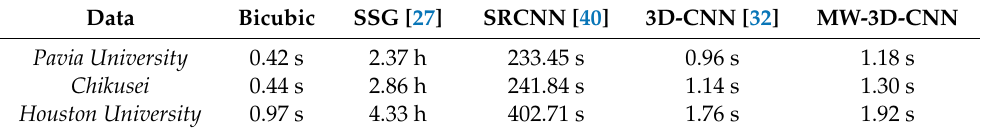
Table 3. The running time of di ff erent SR methods by an upscaling factor of two. Data Bicubic SSG [27]